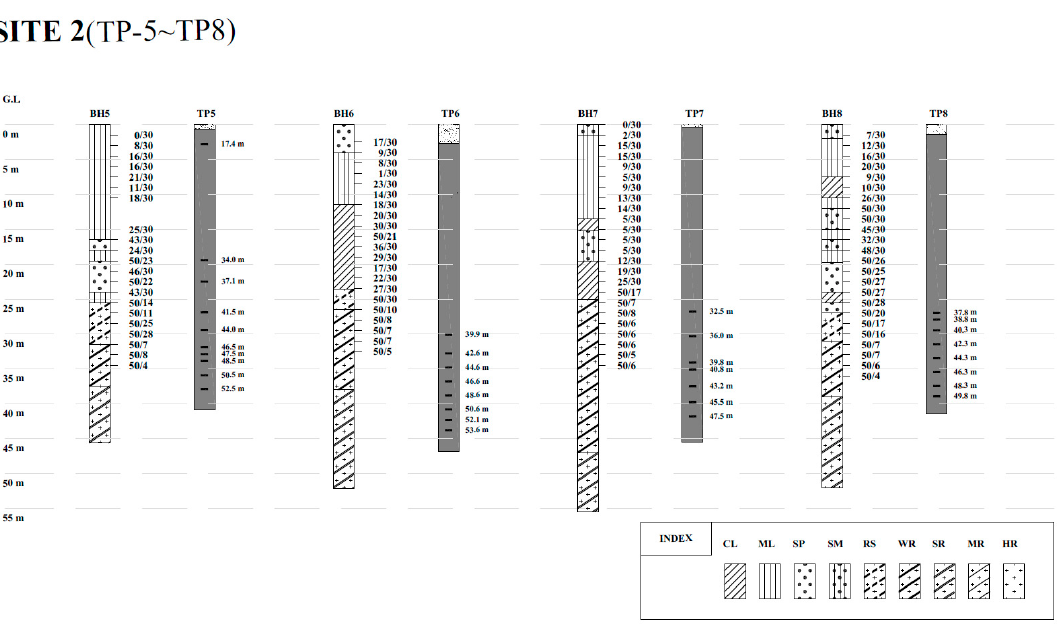
Figure 2. Site investigation results (Site 2).